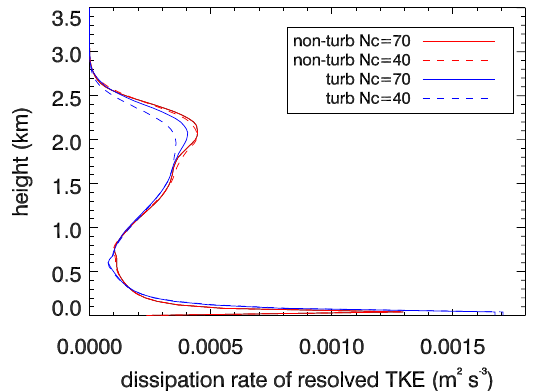
Figure 7. Dissipation rate of resolved TKE (m 2 s − 3 ) for the non- turbulent and turbulent microphysics simulations for the control ( N c = 70) and a reduced cloud droplet number concentration of N c = 40cm − 3